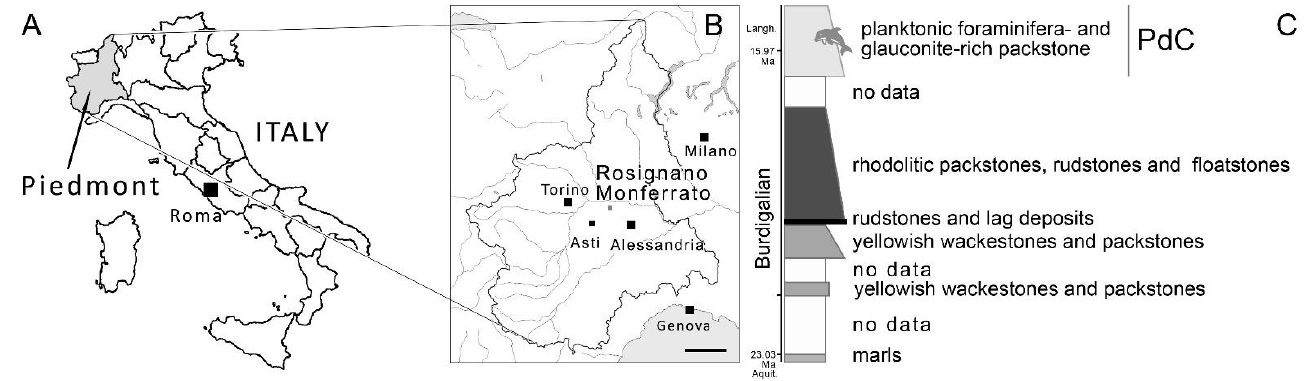
Figure 1. Locality of the discovery of MGPT-PU 13881/-4. ( A ) Italian peninsula with Piedmont highlighted in gray. ( B ) Piedmont showing Rosignano Monferrato. Scale bar equals 50 km. ( C ) Scheme of the stratigraphic column at Rosignano Monferrato showing the principal lithologies, the occurrence of MGPT-PU 13881/-4, and a chronological scale in million years (Ma). Caption: Aquit., Aquitanian; Langh., Langhian; PdC, Pietra da Cantoni. The dolphin icon indicates the approximate position of the find in the stratigraphic column.